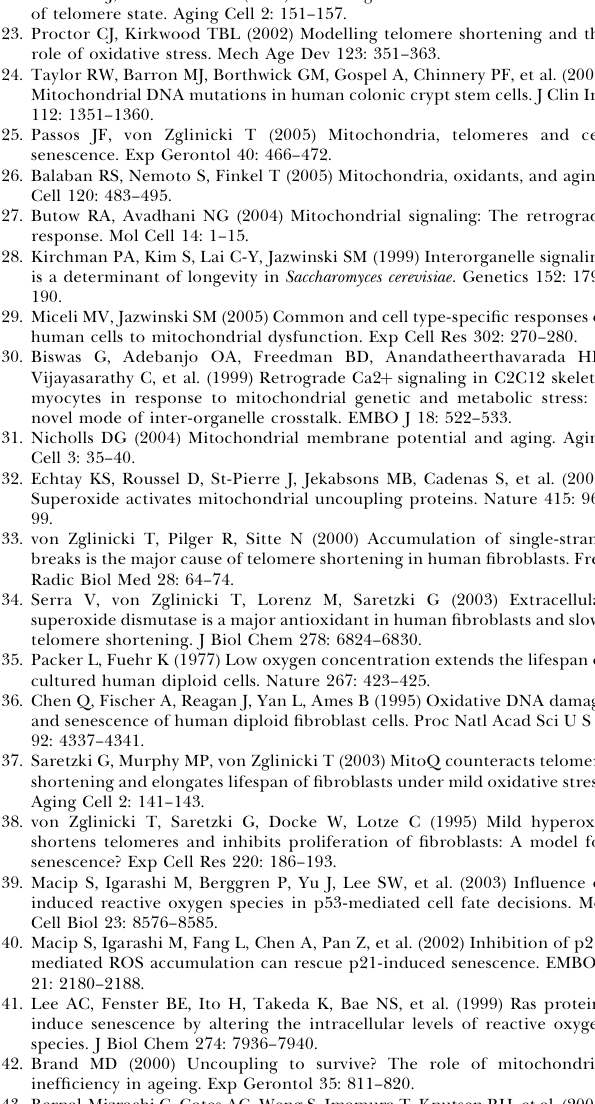
Table S2. KEGG Pathway Functional Enrichment Analysis: 20 Most Statistically Significant Annotation